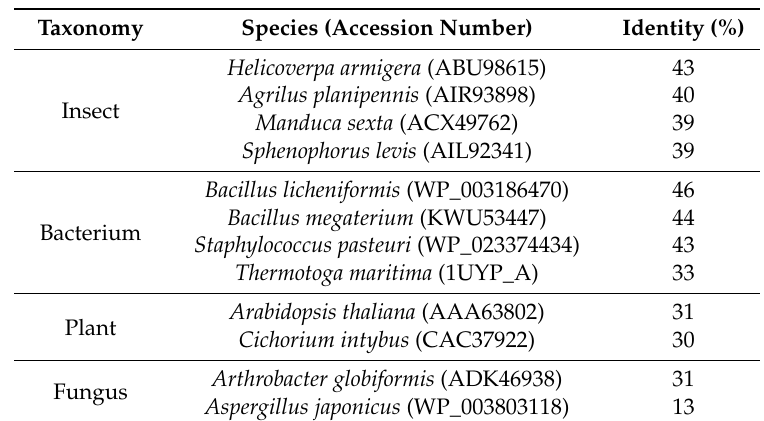
Figure 1. Multiple sequence alignments of β -FFase from Bombyx mori (NP_001119721), Manduca sexta (ACX49762), Agrilus planipennis (AIR93898), Sphenophorus levis (AIL92341), Bacillus licheniformis (WP_003186470), Thermotoga maritima (PDB: 1UYP_A), Arabidopsis thaliana (AAA63802) and Aspergillus japonicus (ADK46938). The letters with black background are 100% identical among the sequences. The characters with pink background show >75% identity among the sequences. Asterisks indicate the putative substrate-binding sites. The three conserved motifs are boxed, in which each putative catalytic residue is indicated by a triangle. The organism names are presented with different colors (red for insect, blue for bacterium, green for plant and brown for fungus). Table 1. Identity of BmSUC1 with some β -FFases from other species.